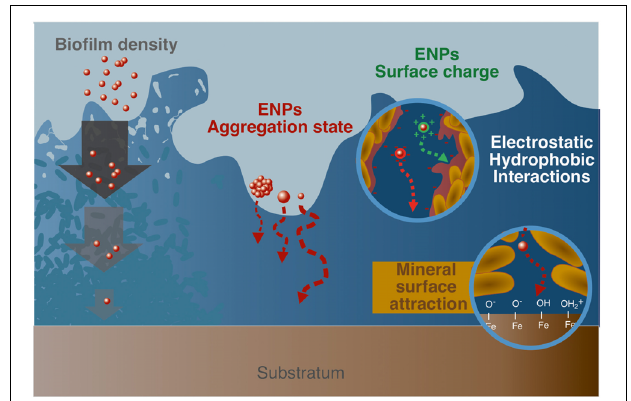
FIGURE 2 | Parameters controlling ENPs migration within biofilms. From left to right, biofilm density and permeability that can limit access to the deepest layers; aggregation state and size of ENPs; ENPs surface charge that controls associations with the biofilm matrix (EPS and cells) through electrostatic and hydrophobic interactions, with for instance positively charged ENPs that tend to interact strongly with the negatively charged biofilm matrix; complexation of ENPs with the mineral substrate surface that partly drives ENPs transport through the biofilm